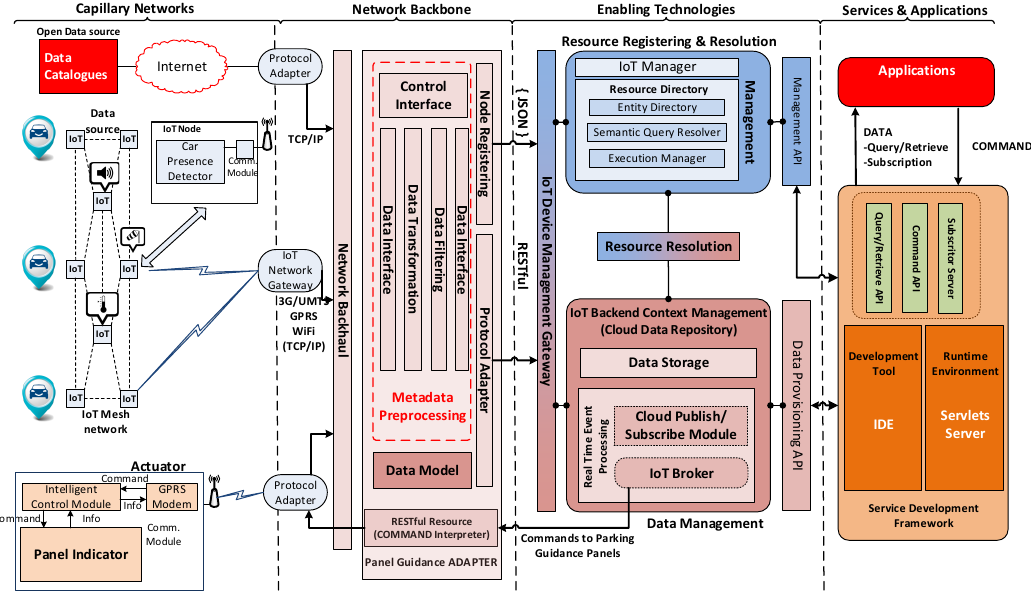
Figure 2. Cloud and internet of things (IoT) -enabled smart city platform high-level architecture.